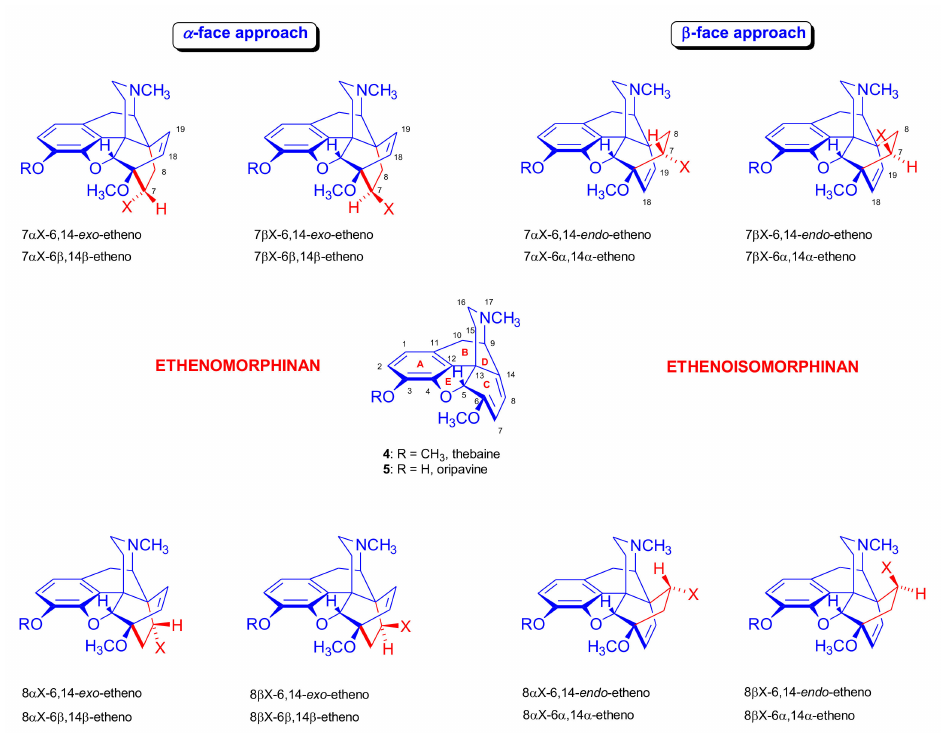
Figure 4. The eight theoretically possible isomers from the Diels–Alder reaction of thebaine ( 4 ) and/or oripavine ( 5 ) with CH 2 =CH-X type of molecule as the asymmetrical